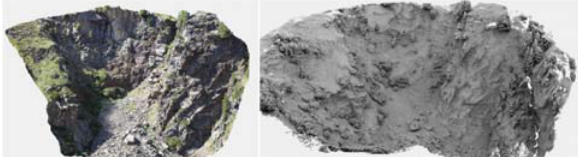
Figure 8. Input imagery and classification